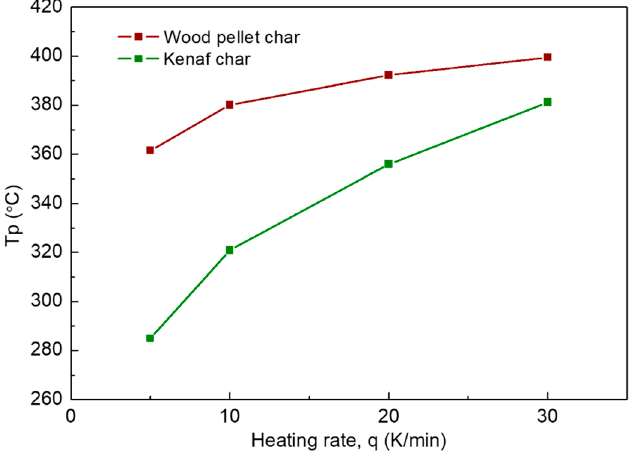
Figure 7. Peak temperature at the maximum reaction rate of the various heating rate experiments.